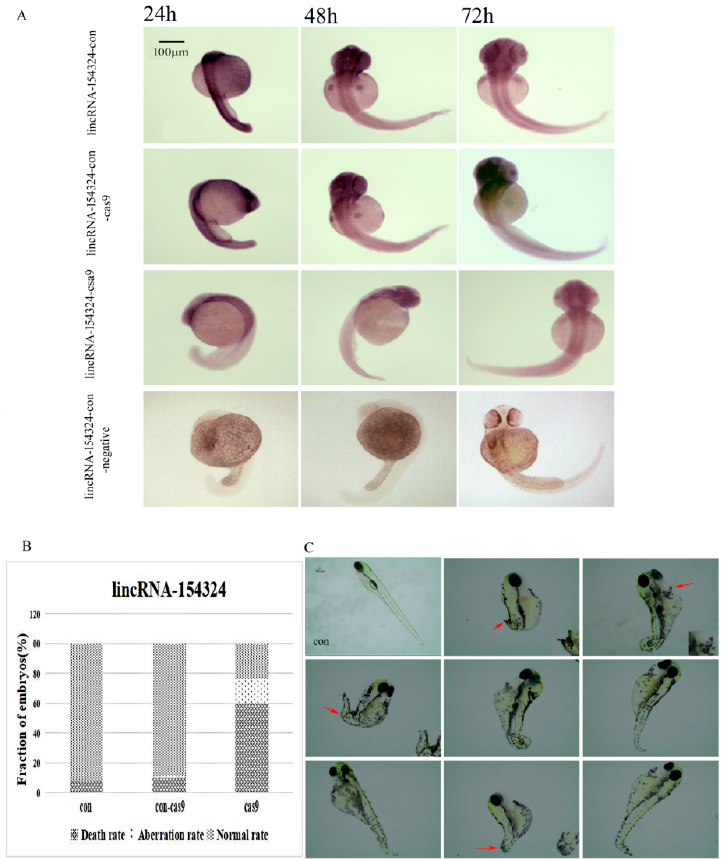
Figure 10 . The expression and morphology of the lincRNA-154324 knockout larvae. ( A ) LincRNA-154324 spatial expression in the lincRNA-154324-con, lincRNA-154324-con-cas9 (a control group in which only cas9 was injected), lincRNA-154324-cas9, and lincRNA-154324-con-negative (a negative control group for WISH) groups at different stages of zebrafish embryogenesis. Scale bars: 100 µ m. ( B ) Frequency of CRISPR/Cas9-micro-injection phenotypes in injected embryos. ( C ) The morphological results after lincRNA-154324 gene knockout at 7 dpf. con: control group. Red arrow: pointing to the deformed part. Scale bars: 100 μ m.